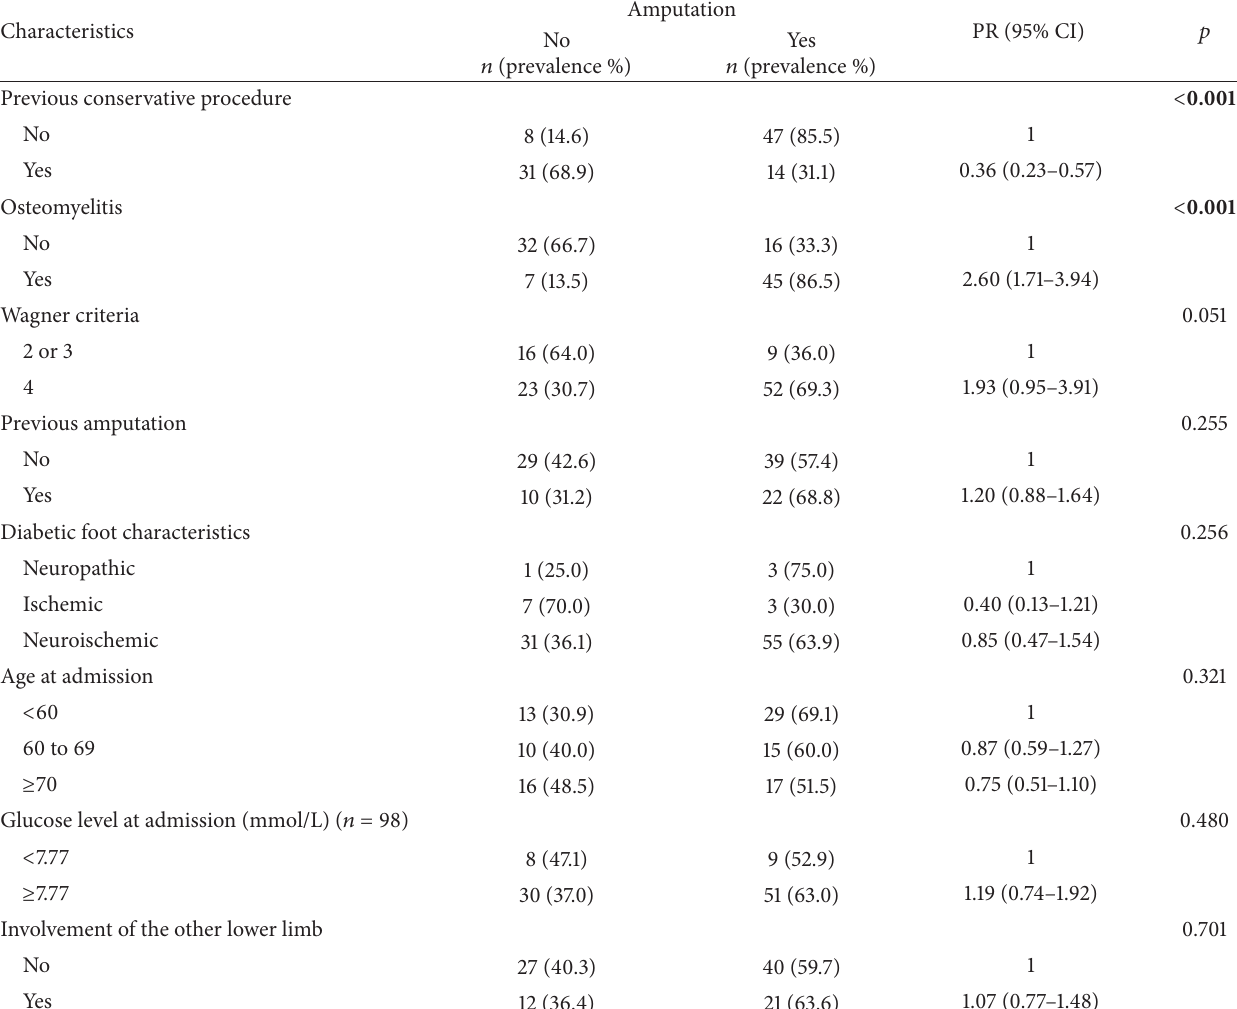
Table 4: Distribution of patients with diabetes by disease characteristics at admission in relation to foot amputation.